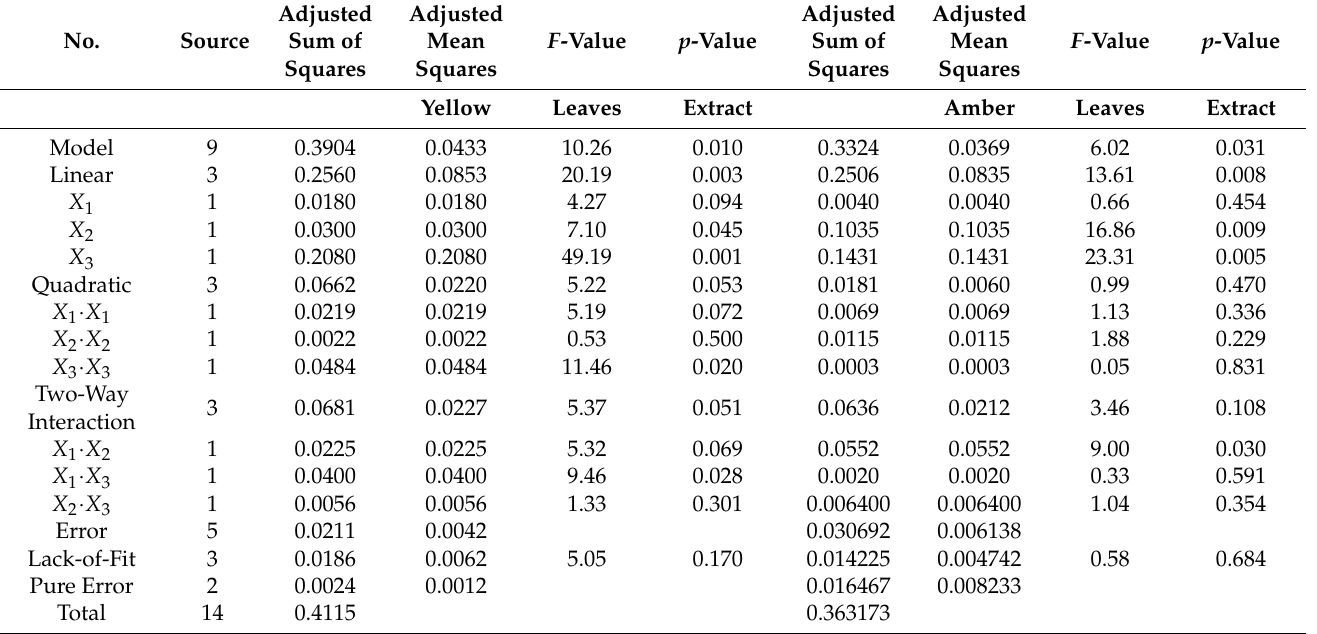
Table 4. The analysis of variance for the total extraction yield of P. persica yellow leaves and amber